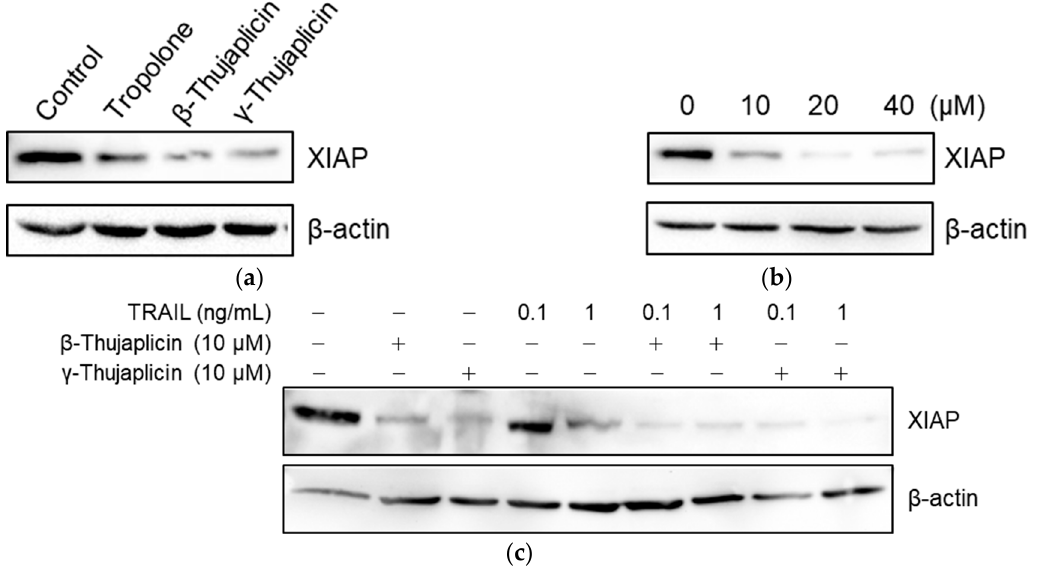
Figure 6. Decrease in XIAP protein levels in NCI-H460 cells following tropolone, β -thujaplicin, and γ -thujaplicin treatments. ( a ) NCI-H460 cells were treated with 10 µM of tropolone, β -thujaplicin, and γ -thujaplicin for 24 h. ( b ) NCI-H460 cells were treated with 0, 10, 20, and 40 µM of β -thujaplicin for 24 h. ( c ) NCI-H460 cells were cotreated with the indicated concentrations of TRAIL and β -thujaplicin or γ -thujaplicin for 24 h. In ( a – c ), cell lysates were subjected to western blot analysis using XIAP antibody.